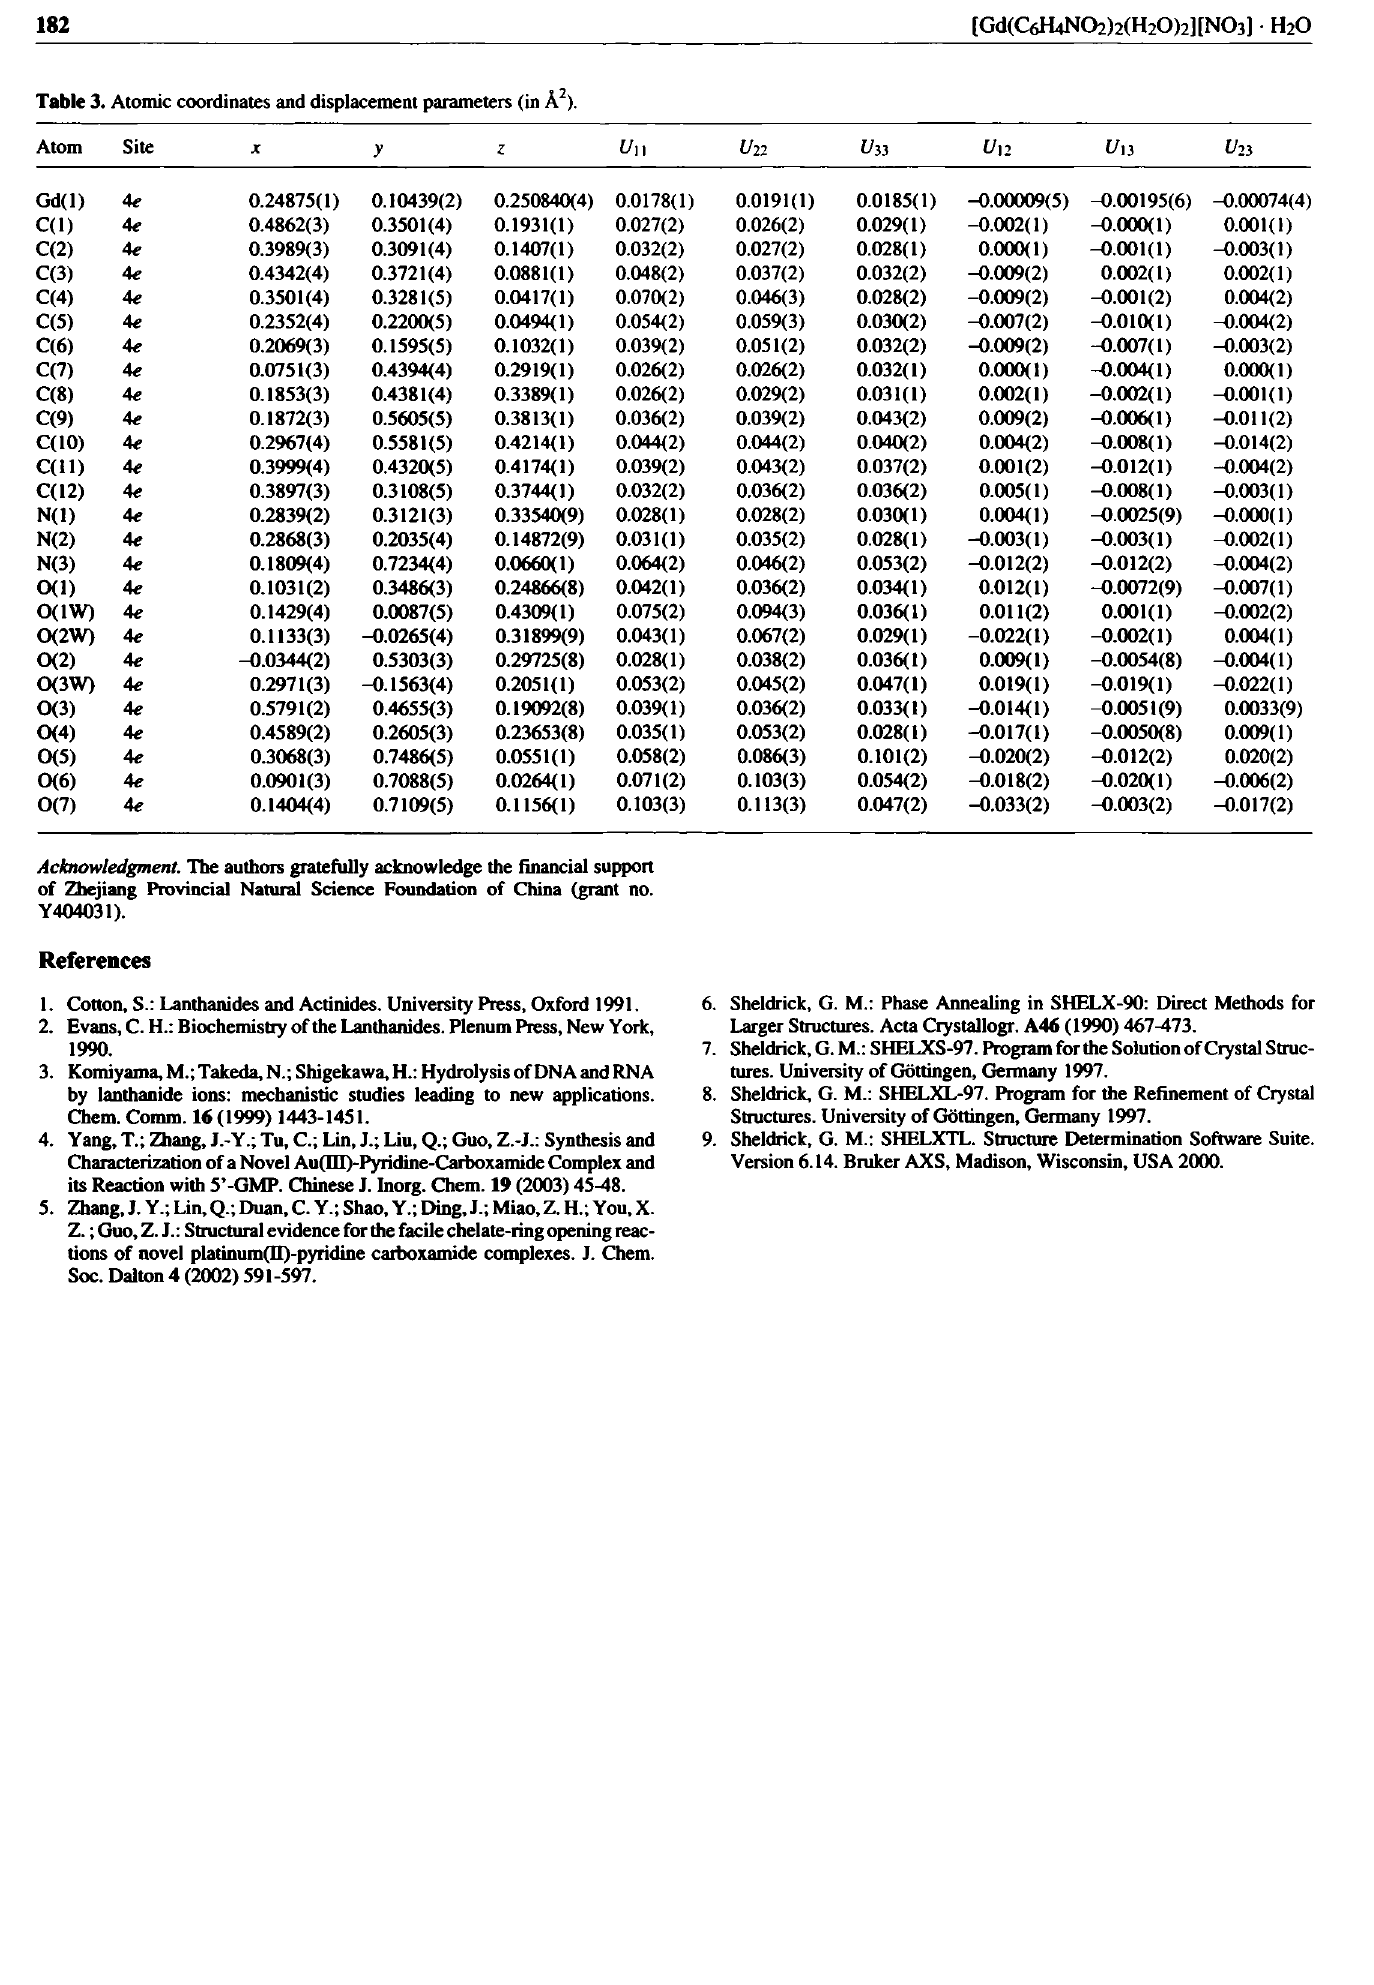
Table 3. Atomic coordinates and displacement parameters (in Ä 2